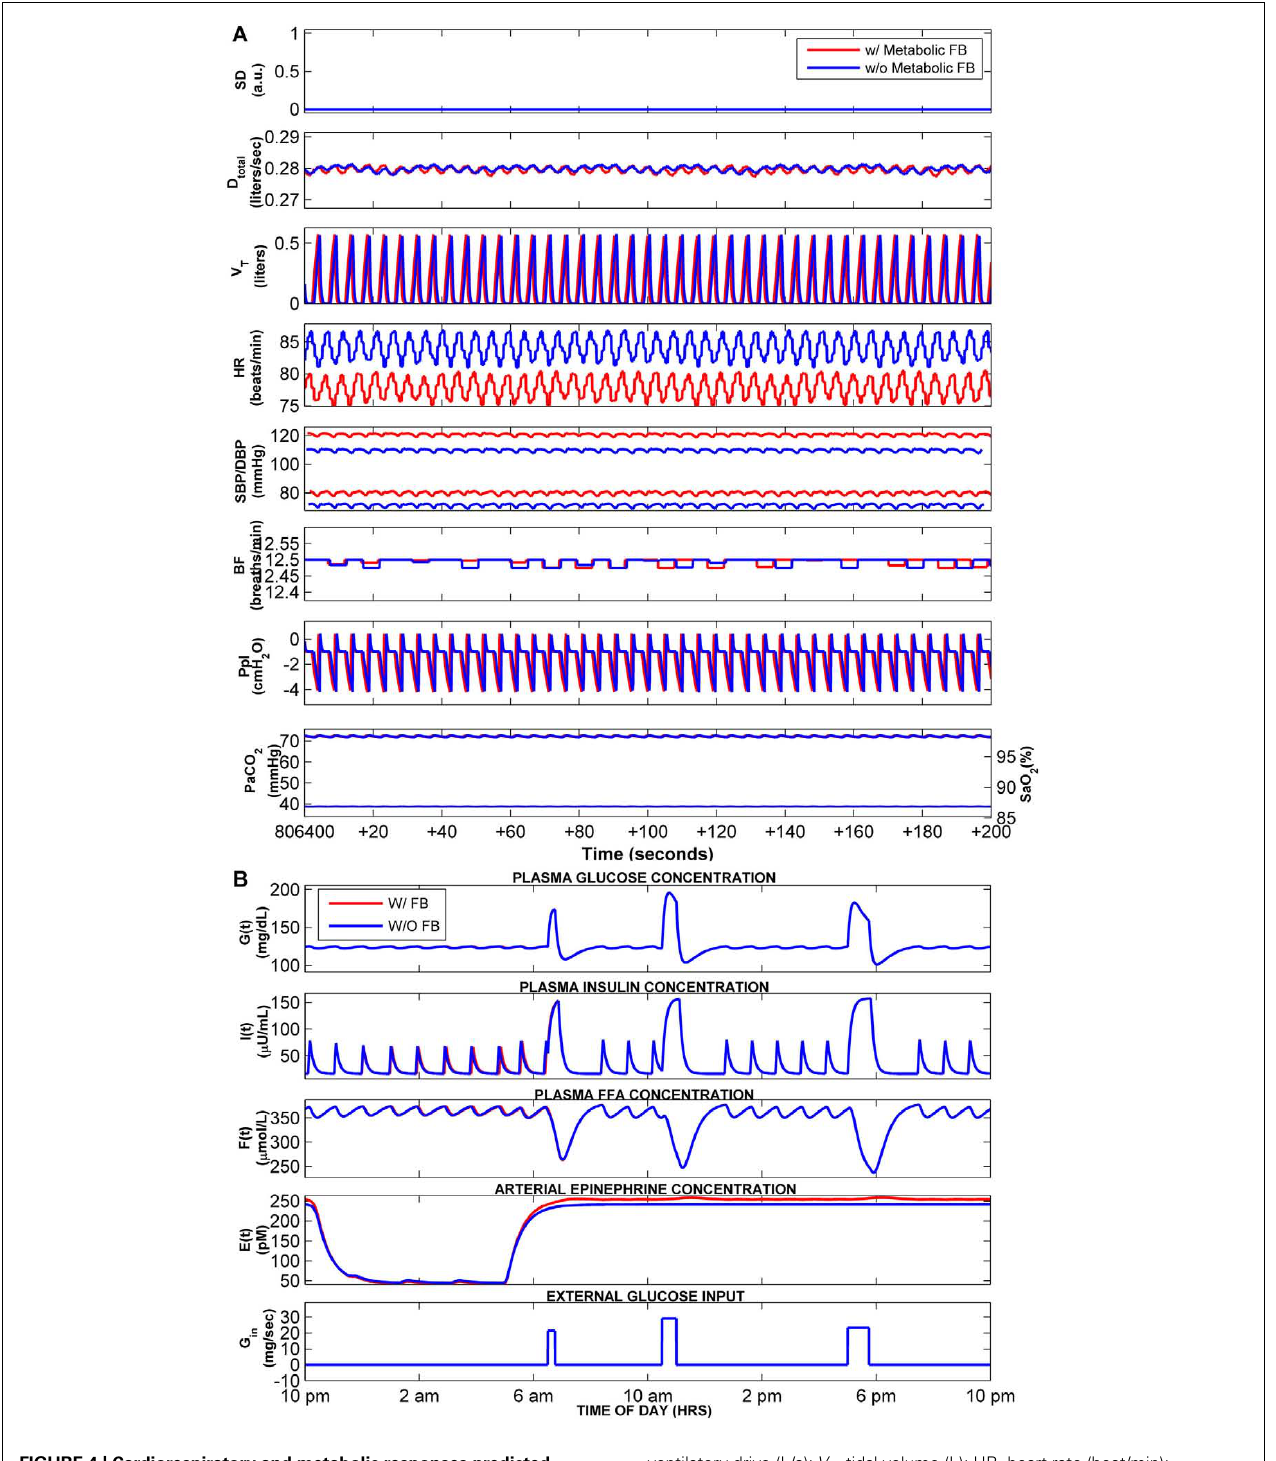
ventilatory drive (L/s); V T , tidal volume (L); HR, heart rate (beat/min); SBP/DBP, systolic and diastolic blood pressure (mmHg); BF, breathing frequency (breaths/min); P pl , pleural pressure (cmH 2 O); P a CO 2 (Thin Lines), arterial PCO 2 (mmHg); SO 2 (Thick Lines), saturation of oxygen (%). (B) Predicted time-courses of plasma glucose, insulin, FFA, epinephrine, and the external glucose inputs to the model (representing three meals during